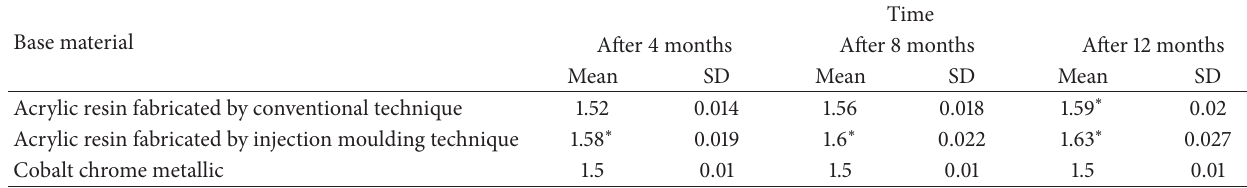
Table 2: The dimensional changes (mean and standard deviation) of the three denture base materials over time.